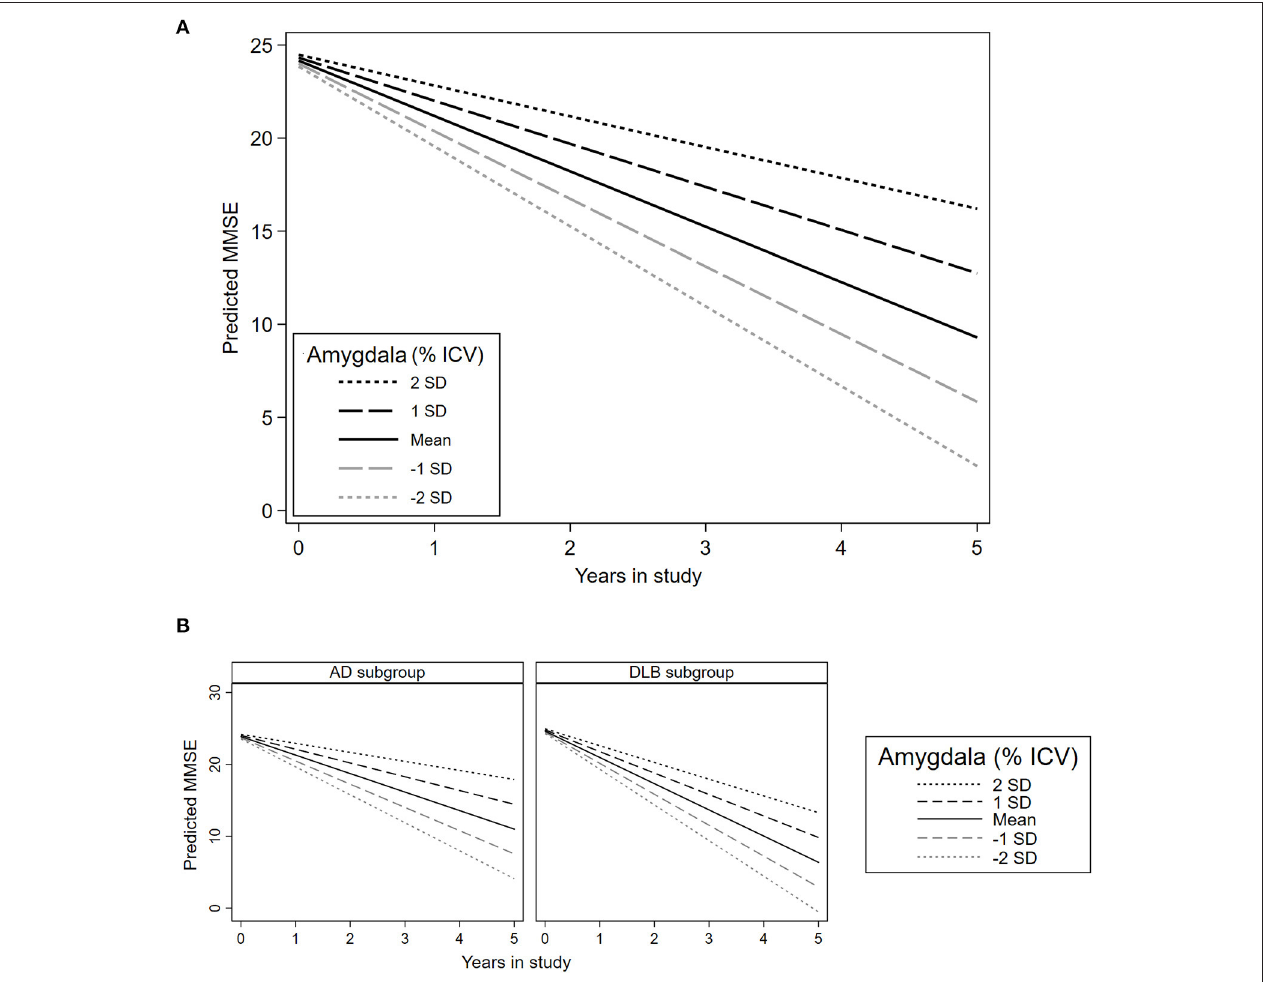
FIGURE 5 | Association between amygdala volume and trajectories of global cognition in the total sample and each diagnosis subgroup. MMSE, Mini-mental state examination; SD: Standard deviation. (A) Predictions in the total sample. (B) Predictions in the AD and DLB subgroups. This plot is based on the estimations presented in Table 2B , Model 4 (adjusted for time in study, age, gender, diagnosis, and center of sMRI